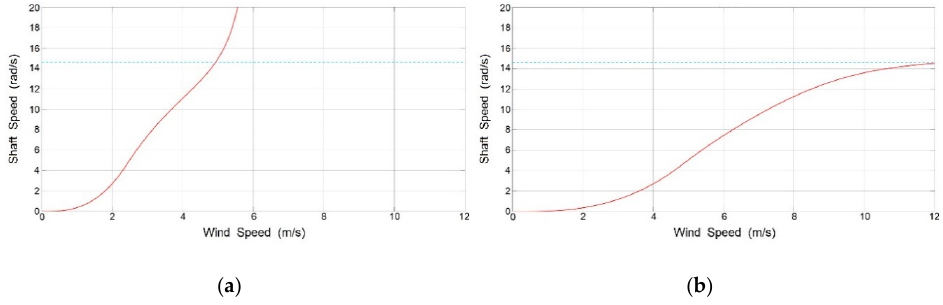
Table 2. Statistical analysis of meteorological variables. Meteorological